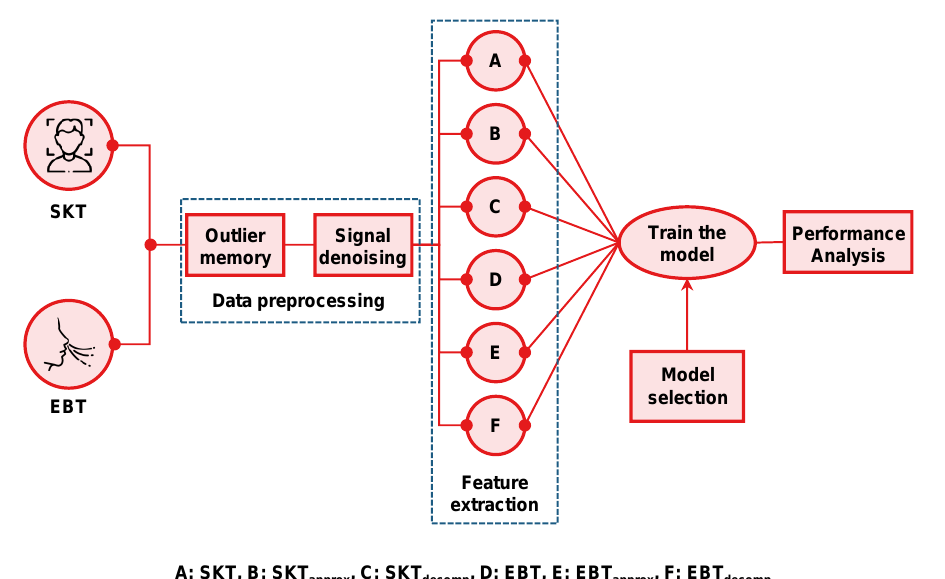
Figure 4. Overall block diagram for making individual thermal sensation prediction model.